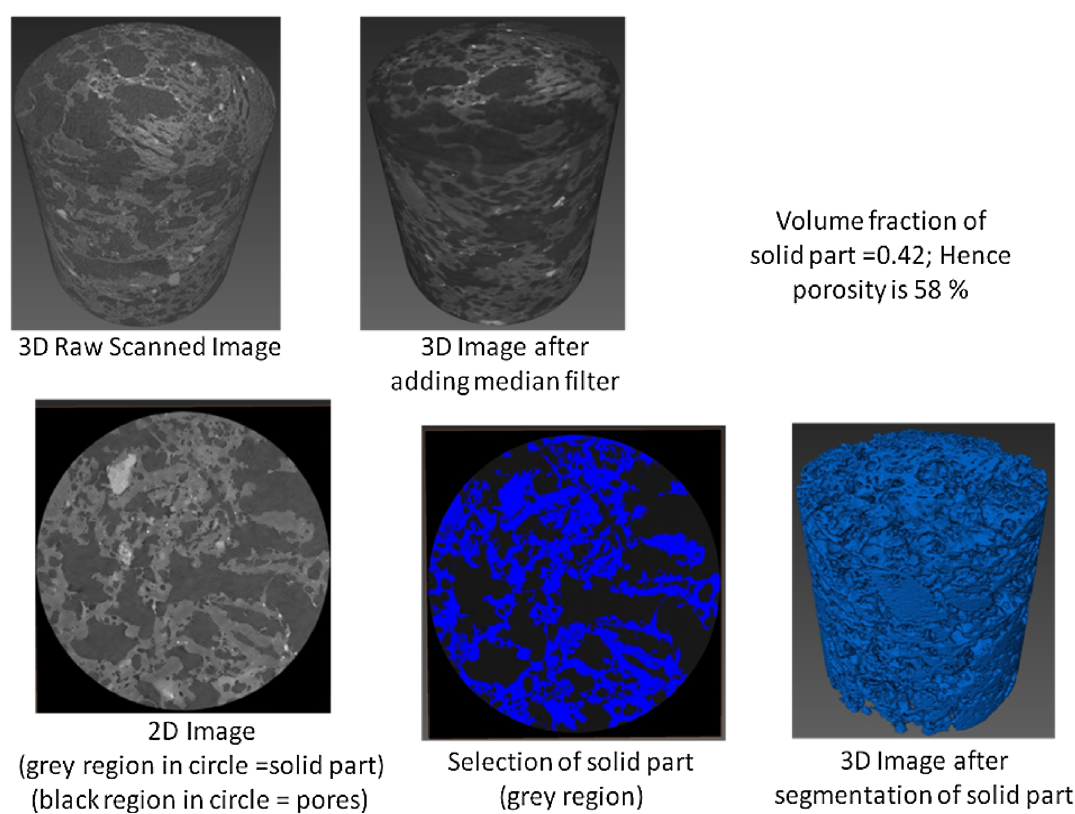
Fig. 10 X- ray computed tomography showing pore size distribution in coke